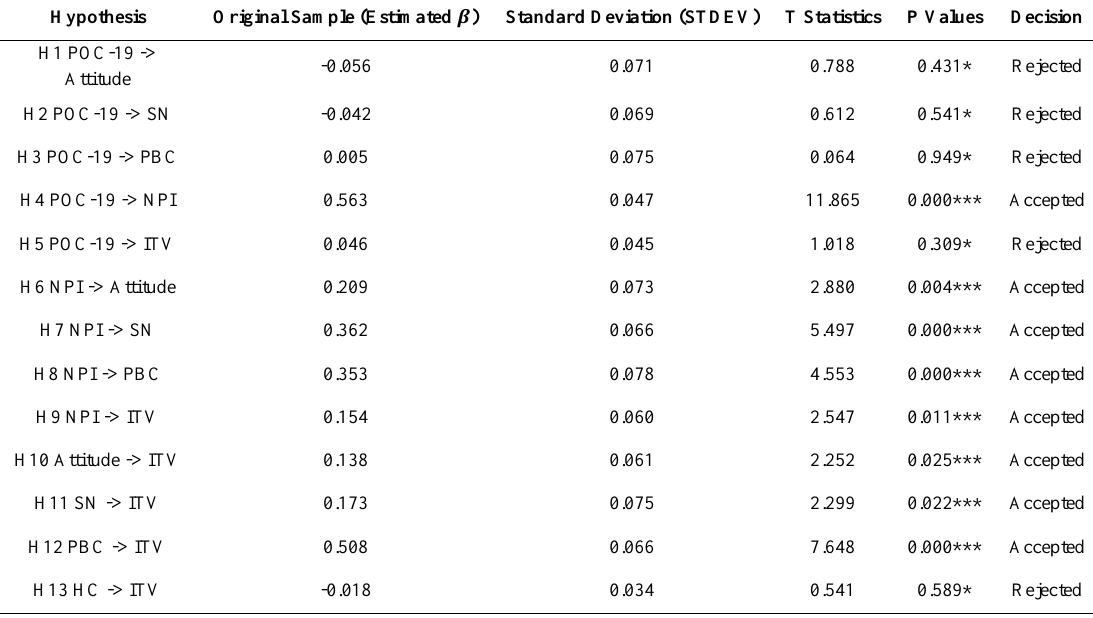
Table 6. Hypotheses